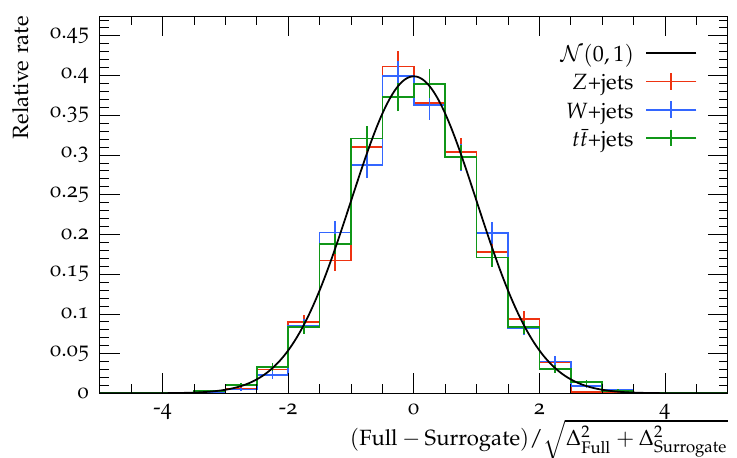
Figure 9: Distribution of deviations between the full and the surrogate approach in S HERPA from a comparison in almost 16,000 observable bins for all three